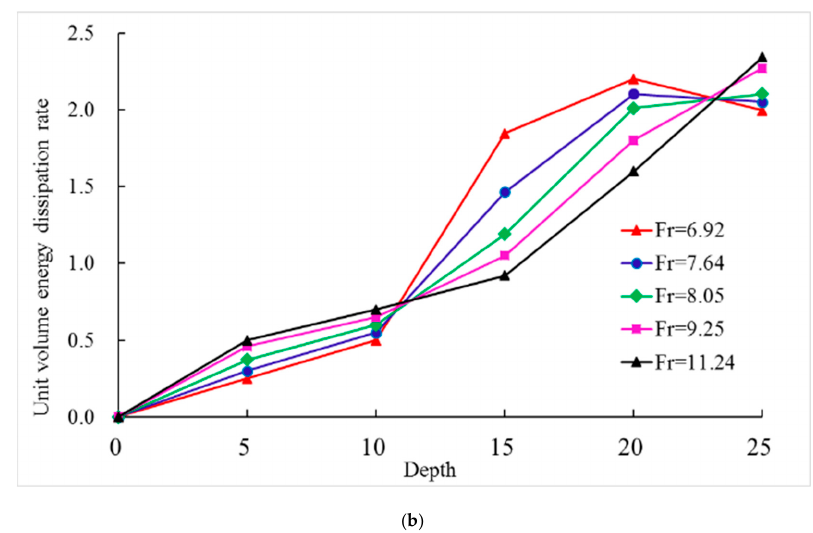
Figure 9. Energy dissipation rate. ( a ) Energy dissipation rate; ( b ) Unit volume energy dissipation rate.